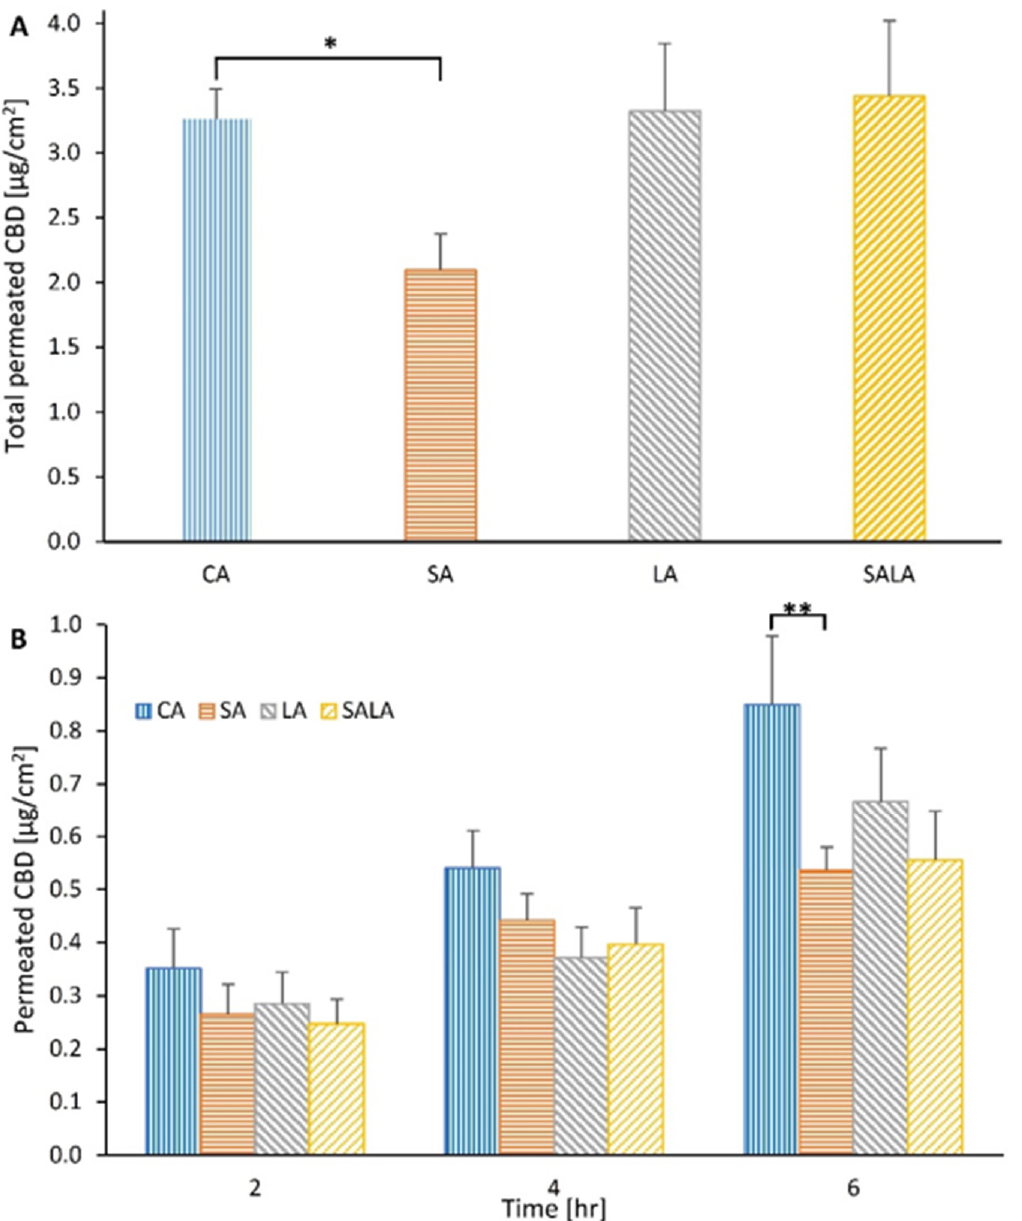
Figure 5. Skin retention of CBD after 6-h application: ( A ) * p value < 0.05 between compared groups, and percutaneous permeation of CBD delivered via lipid-stabilized nanoparticles; and ( B ) ** p value < 0.01 between compared groups. The p -value was calculated as a two-tailed homoscedastic Student’s t -test. Values are presented as mean ± SEM.